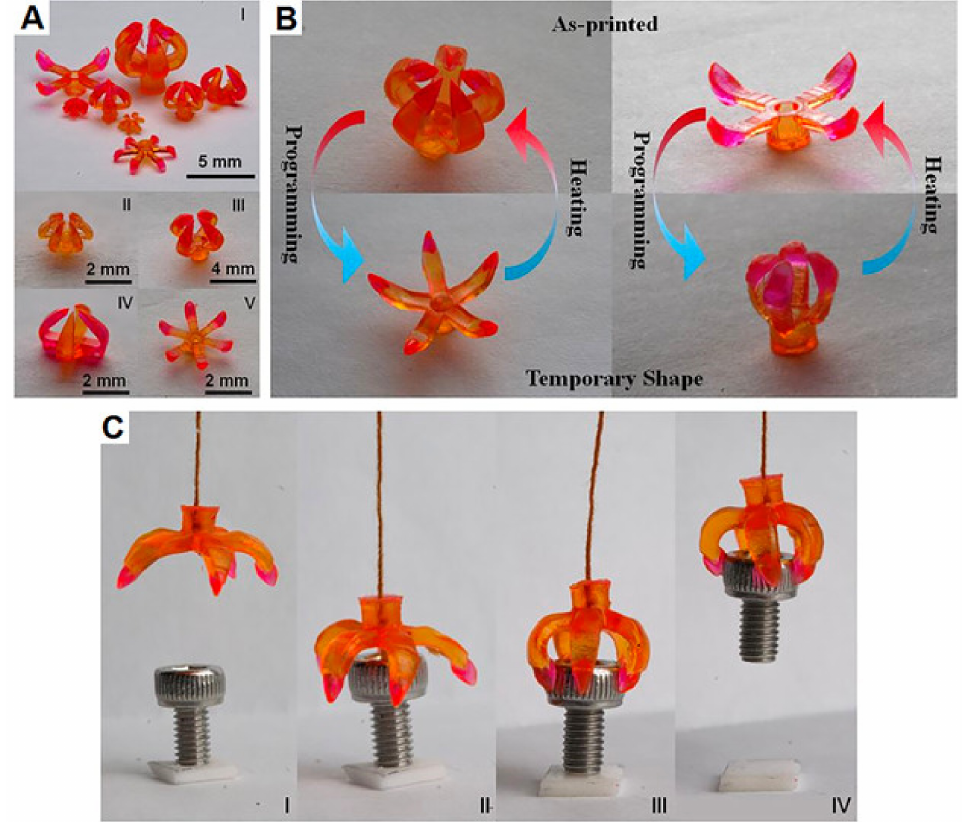
Figure 17. Grippers printed using 4DP as biorobots. ( A ) Multimaterial grippers of distinctive designs; ( B ) validation of the transition between as printed and brief shapes of multimaterial grippers; and ( C ) photographs of the gripping activity to clutching an object. Reproduced with permission from reference [73] Copyright 2016,